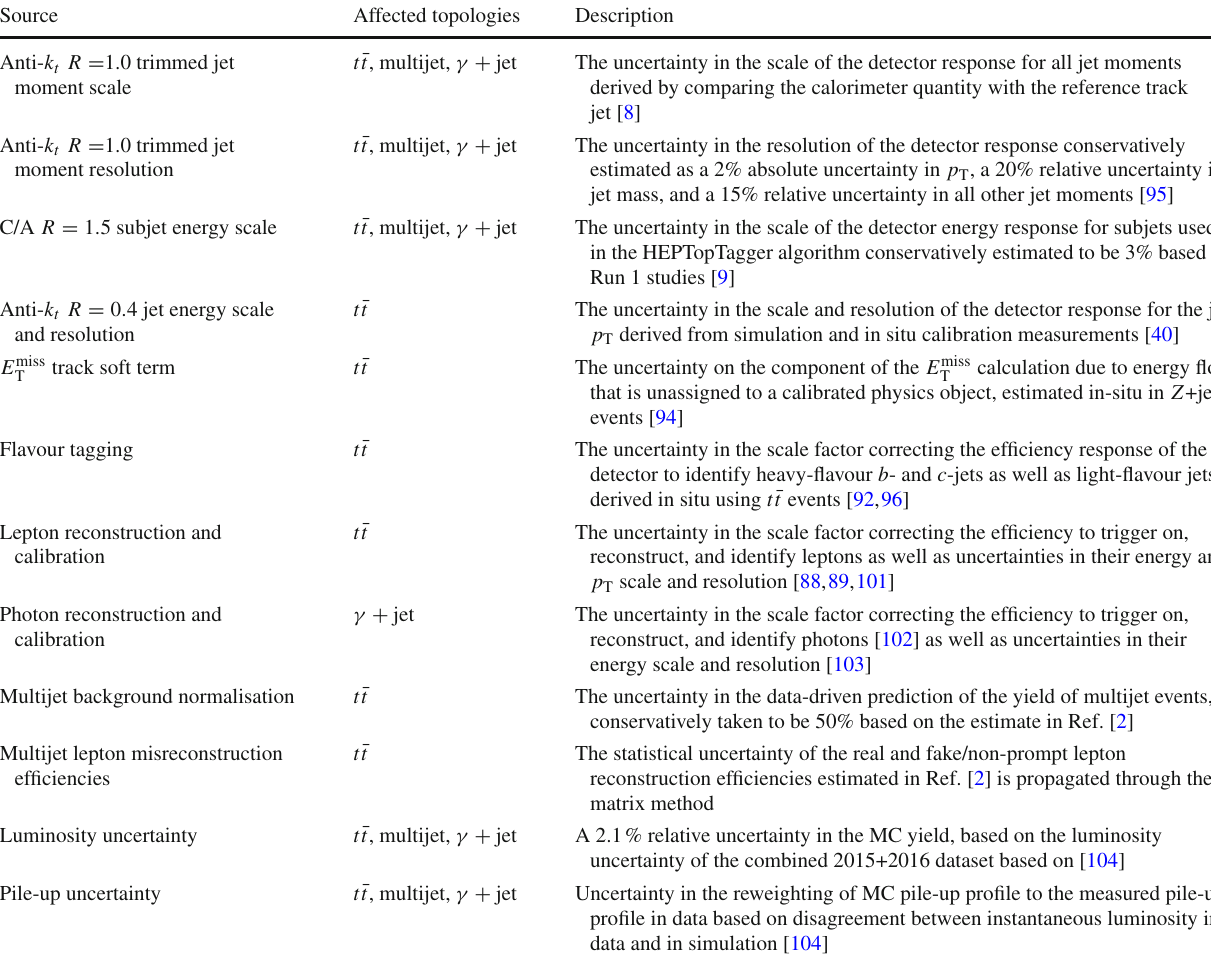
Table 4 Summary of experimental systematic uncertainties considered in the performance measurements in data Source Affected topologies